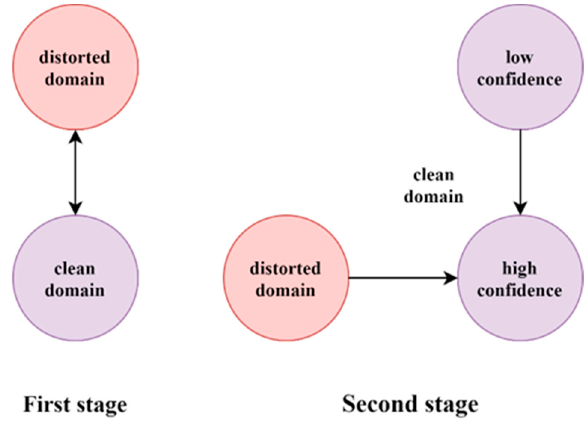
Figure 4. Overview of domain translation.